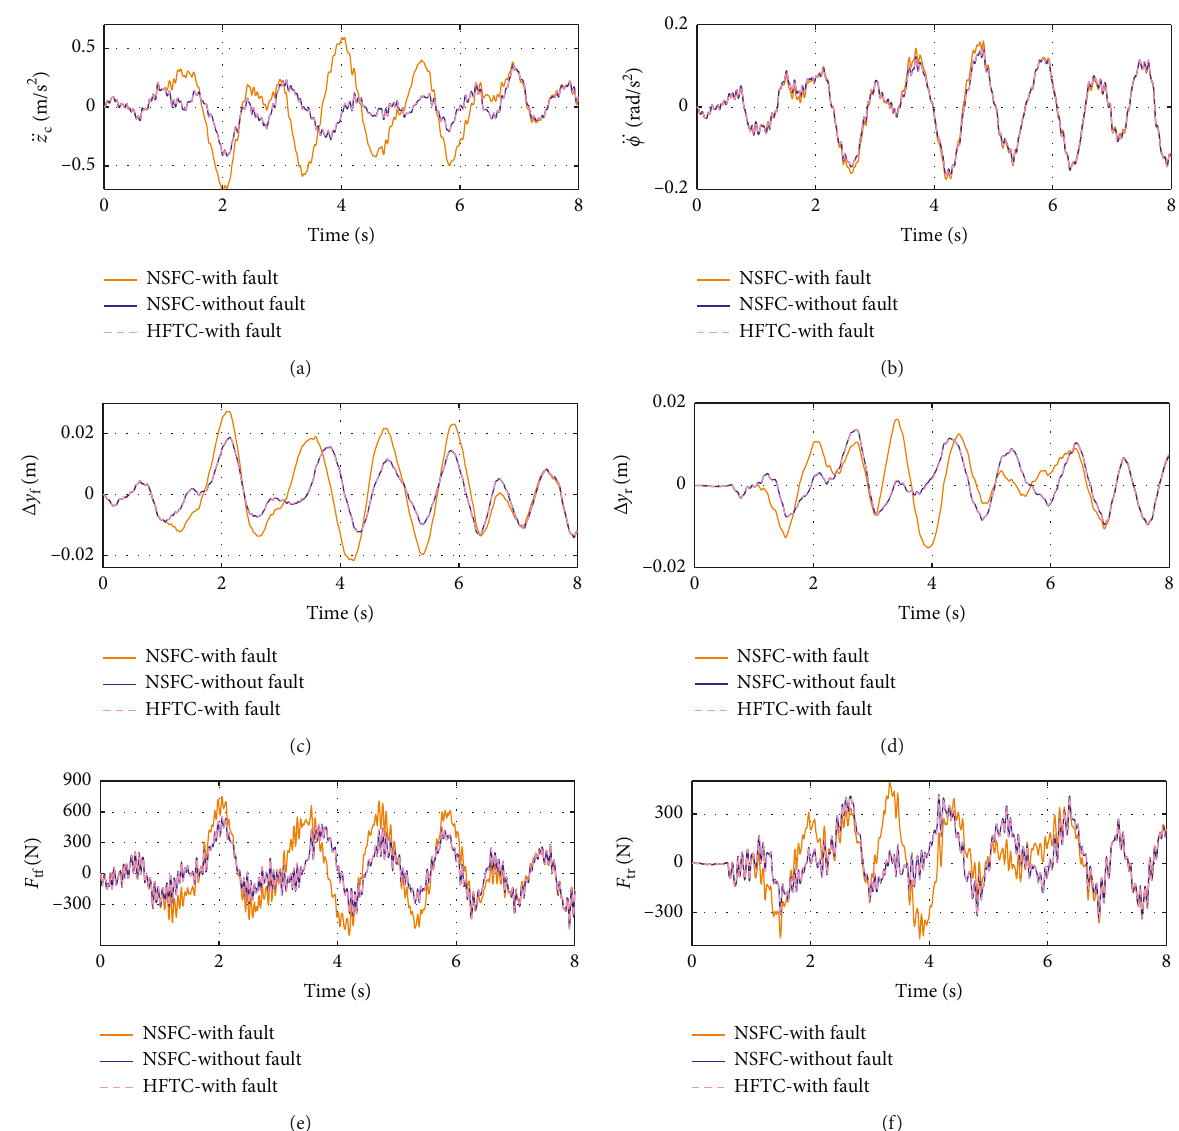
Figure 4: The response comparisons of ASS with the general fault signal under random road